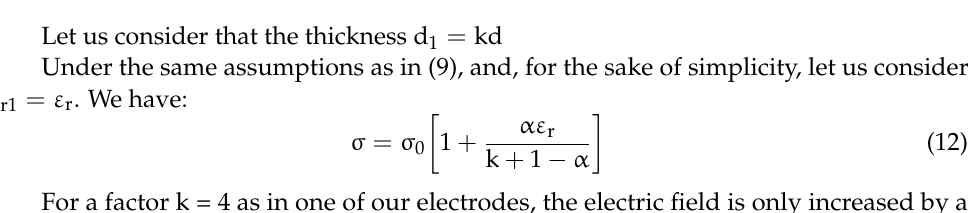
Figure 4. One-dimensional model of the sample in series with a dielectric layer charged with a surface charge σ 0